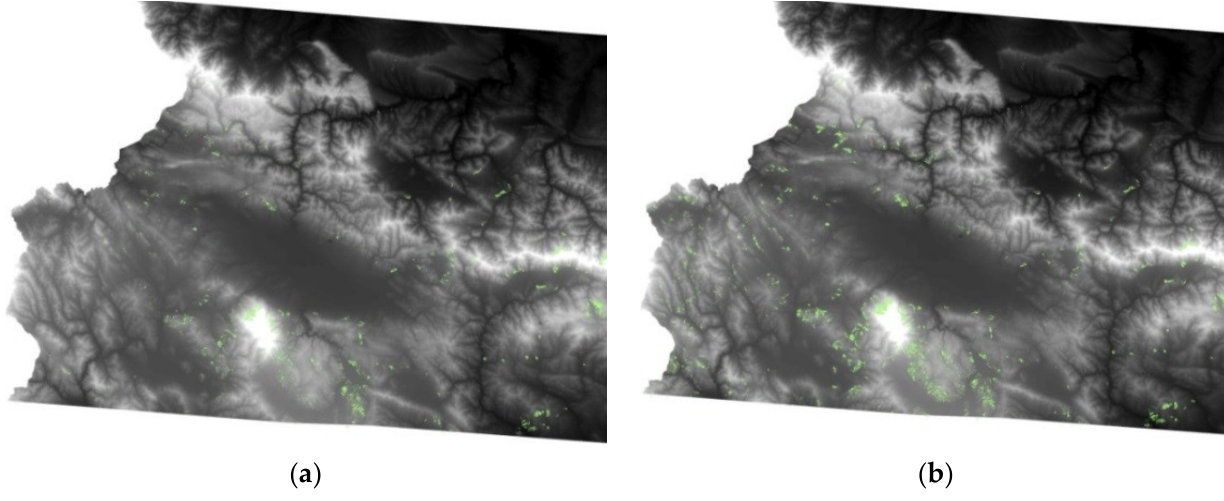
Figure 5. Distribution of coniferous forests (green coloured area) unaffected by drought (DC < 2) at the beginning of August ( a ) and in the middle of August ( b ), Scale 1:1,100,000.